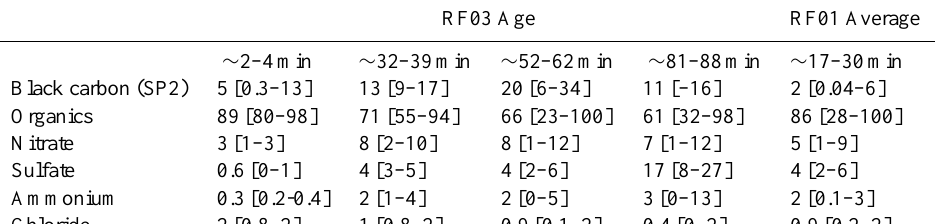
Table 3. Submicron aerosol mass fractions, shown as percentages with uncertainty ranges, considering black carbon, measured by the SP2, as well as non-refractory organics, sulfate, nitrate, ammonium, and chloride, measured by the C-ToF-AMS for the four RF03 plume periods, as well as the RF01 plume average. Data are illustrated in Fig. 3.